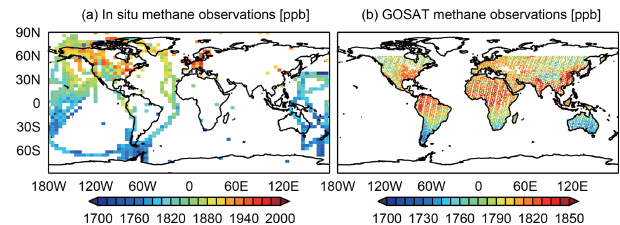
Figure 2. Mean 2010–2017 methane observations from the GLOB- ALVIEWplus ObsPack data product and from GOSAT. The GLOB- ALVIEWplus in situ data are local dry mixing ratios and are aver- aged over the 4 ◦ × 5 ◦ model grid for visibility. The GOSAT data are dry column mixing ratios on a 1 ◦ × 1 ◦ grid from the University of Leicester version 9 Proxy XCH 4 retrieval (Parker et al., 2020), excluding observations over oceans and poleward of 60 ◦ N. Note the difference in color scale between